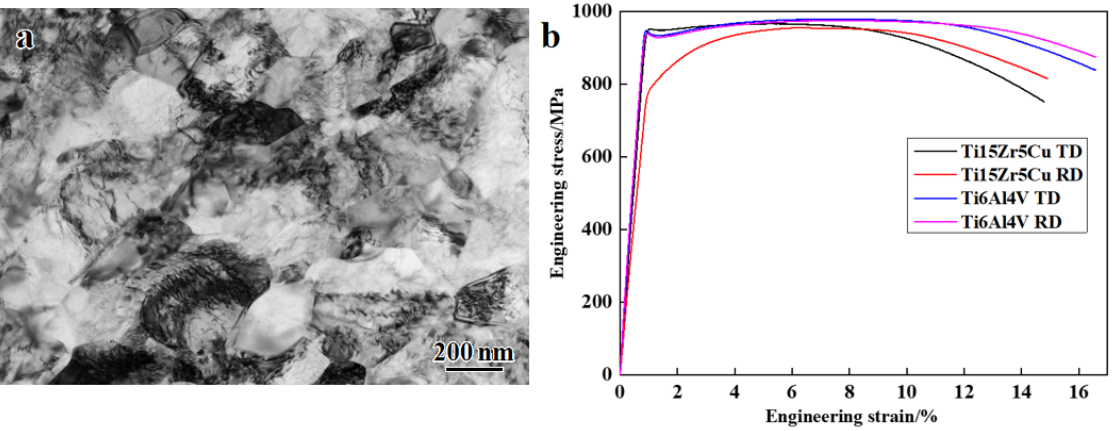
Figure 5. Microstructure and tensile property of the as-deformed ultrafine-grained Ti15Zr5Cu alloy. ( a ) TEM observation; ( b ) room temperature tensile curves.